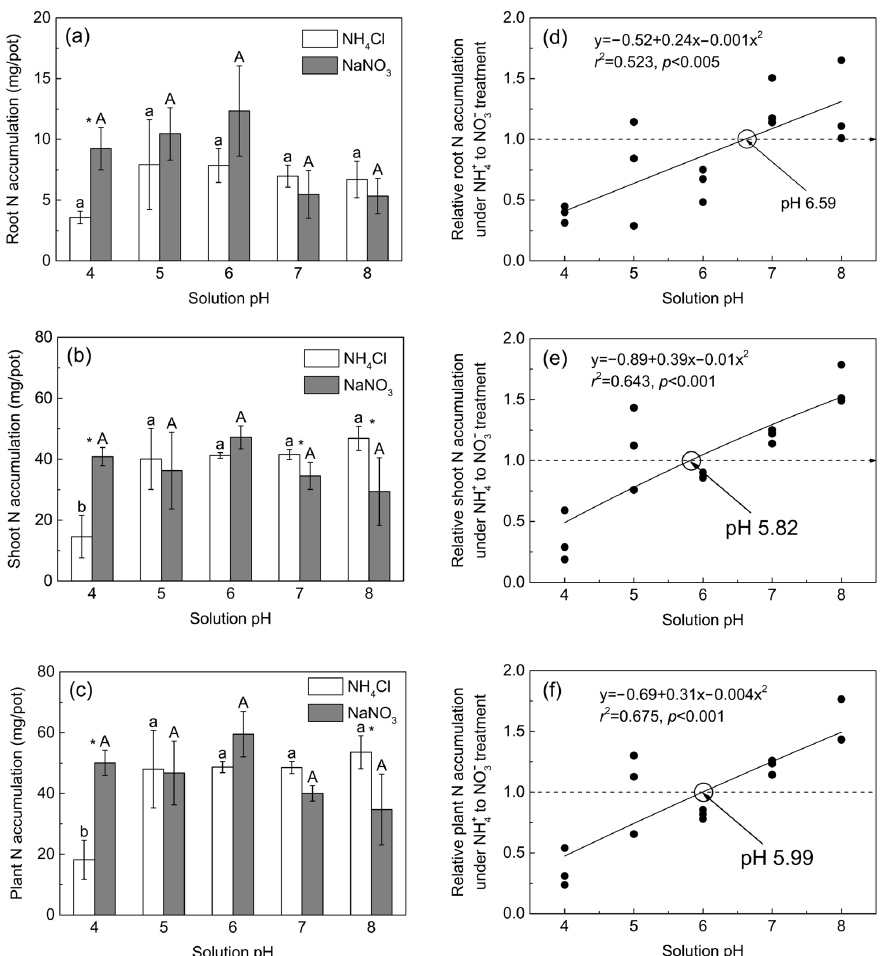
Figure 7. Effect of solution pH on the nitrogen (N) accumulation response of maize to ammonium (NH 4+ ) and nitrate (NO 3 − ) fertilizers under hydroponic conditions. ( a – c ) N accumulations in the root ( a ), shoot ( b ), and total plant ( c ). ( d – f ) Relative N accumulations in the root ( d ), shoot ( e ), and total plant ( f ). Maize seedlings were harvested after 15 days of growth. Relative N accumulations in roots, shoots, and whole plants were calculated as the ratio of N accumulation under NH 4+ treatment to that under NO 3 − treatment. Different lowercase and capital letters above bars indicate significant differences among different solution pHs under NH 4 + and NO 3 − treatments, respectively. Asterisks indicate significant differences between NH 4+ and NO 3 − treatments at the same solution